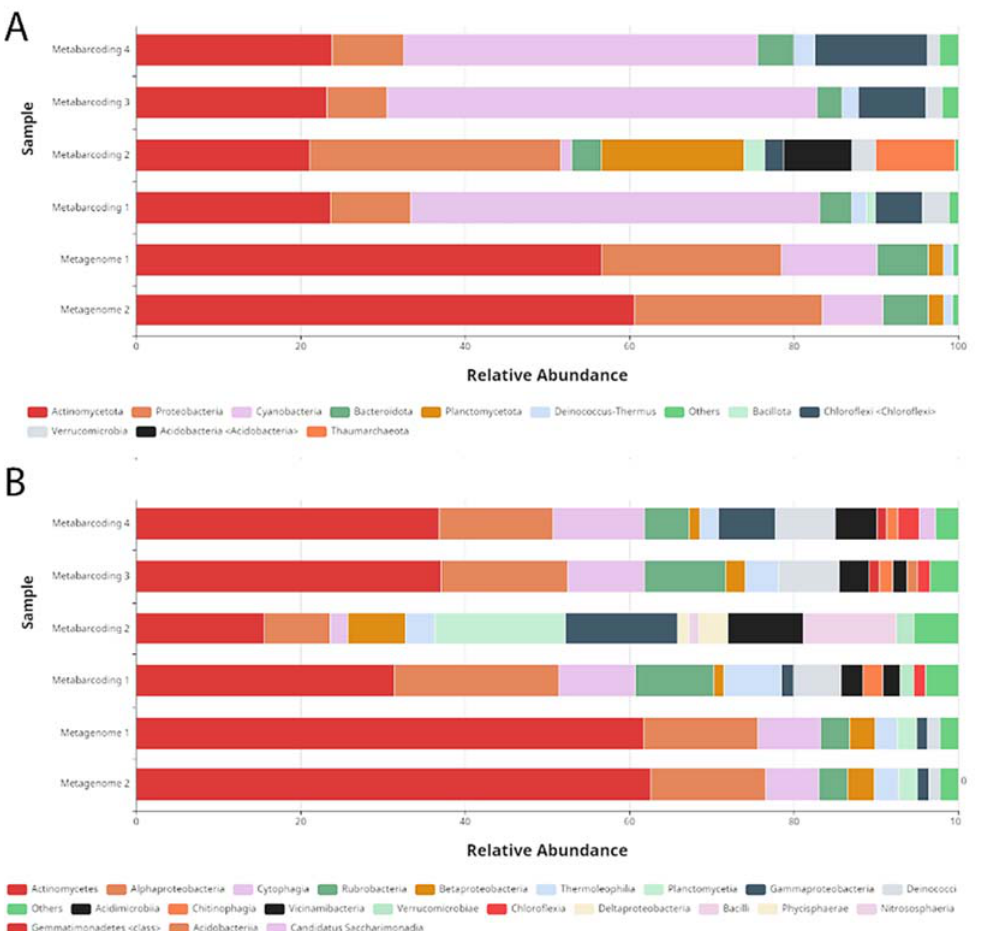
Figure 2. Biodiversity of the Pad2 site. The metagenomic and the metabarcoding datasets were analyzed using the Kraken 2 software and Omicsbox tools. Shown are stacked bar charts of the abundance ( x -axis) of classified reads. For simplicity taxonomic groups with less than 1% abundance are grouped together as others. The same DNA samples (replicate 1 of the four replicates shown) were used for metabarcoding 1 and the metagenomes 1 and 2. ( A ) Phyla; ( B ) classes.